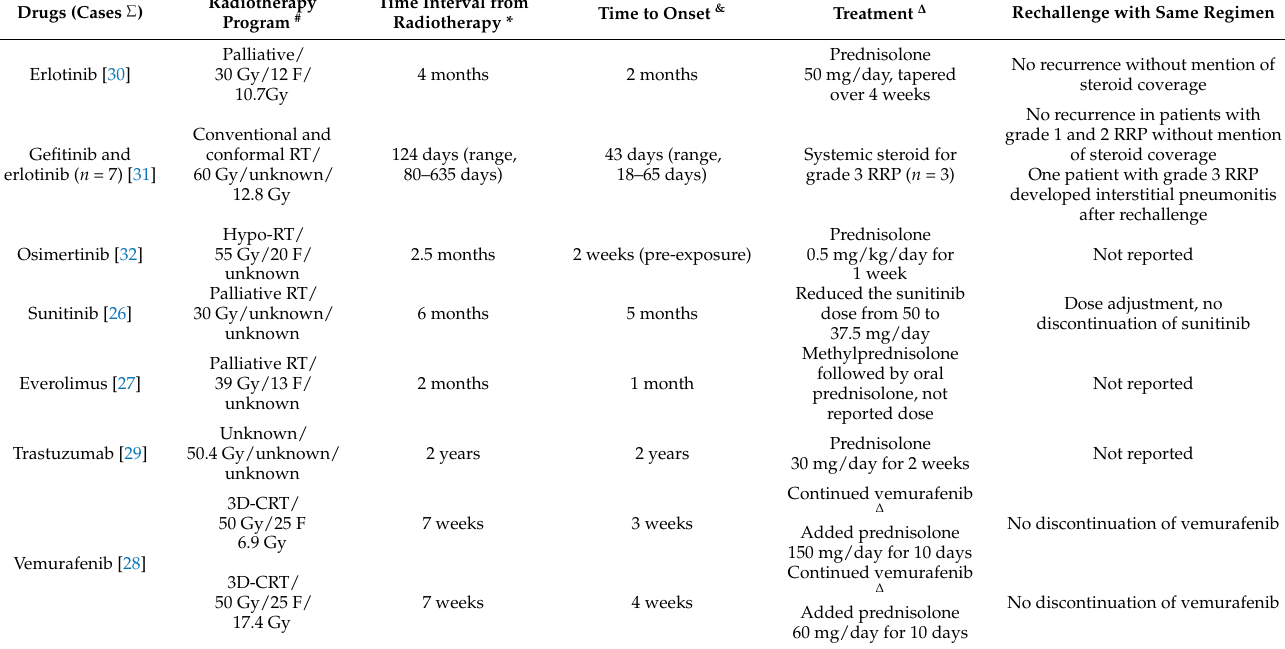
Table 3. Summary of published cases of RRP induced by targeted